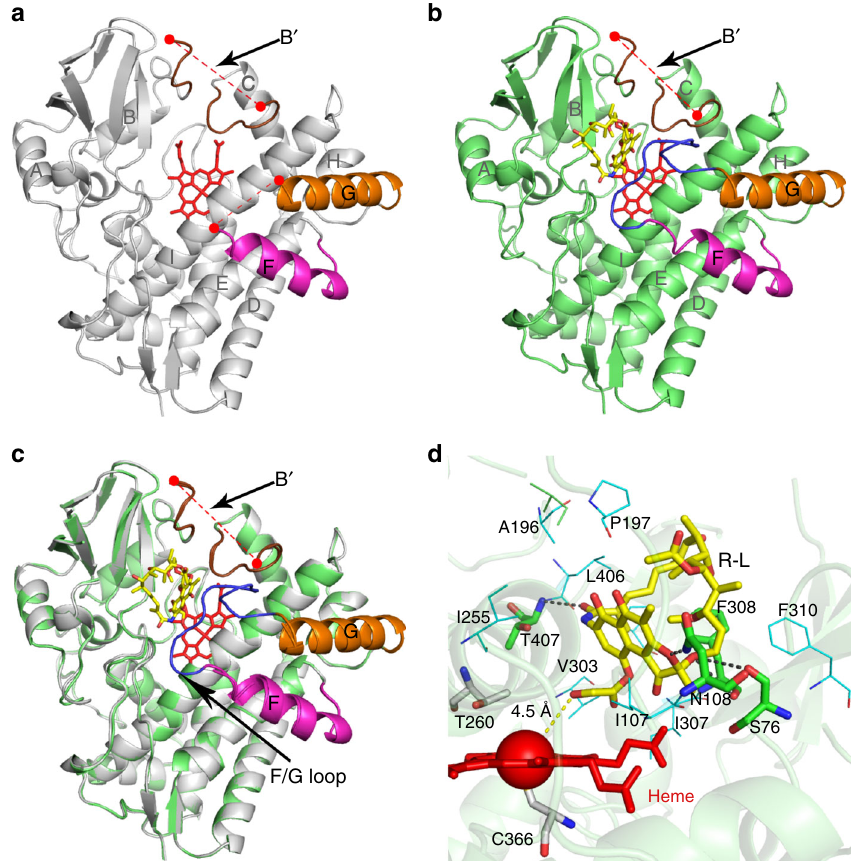
Fig. 4 Structures of Rif16. a Substrate-free Rif16. The disordered B ′ loop (with 83-97 residues missing as shown with the dashed red line) that replaces the typical B ′ helix is shown in brown. The F and G helices are shown in magenta and orange, respectively. The disordered FG loop (192-205 residues) lacks electron density. The heme group is shown as a stick in red. b Substrate-bound Rif16. The B ′ loop in brown remains disordered. The FG loop (here ordered) is shown in blue. c Superimposition of the substrate-free (gray) and the substrate-bound (lime green) Rif16. The black arrows point out the regions that undergo conformational changes upon R-L binding. d The active site of Rif16. The substrate R-L and heme are shown as sticks in yellow and red, respectively, with the heme-iron depicted as a sphere. The key residues forming hydrogen bonds (black dashed lines) with R-L are shown as sticks in green. The residues within 5 Å around the substrate that constitute a large hydrophobic pocket are shown as lines in cyan. The conserved T260 and C366 are shown as sticks in silver. The distances (in angstroms) are indicated by the dashed yellow